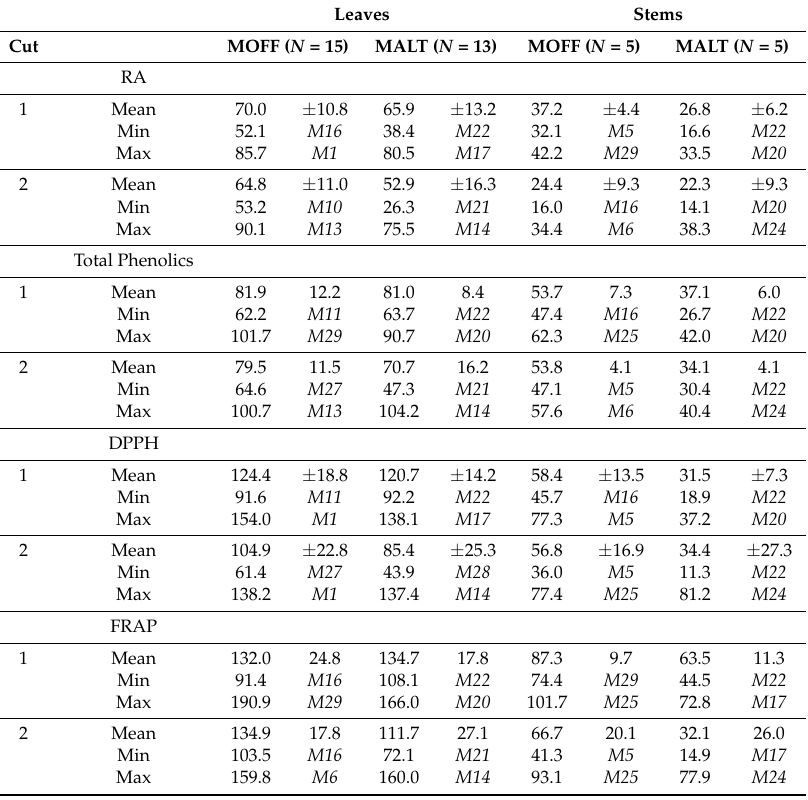
Table 3. Rosmarinic acid (mg/g DM), total phenolics (mg/g DM rosmarinic acid equivalents), DPPH (mg/g DM Trolox equivalents) and FRAP (mg/g DM Trolox equivalents) in leaves and stems of lemon balm subspecies officinalis (MOFF) and subspecies altissima (MALT). Leaves